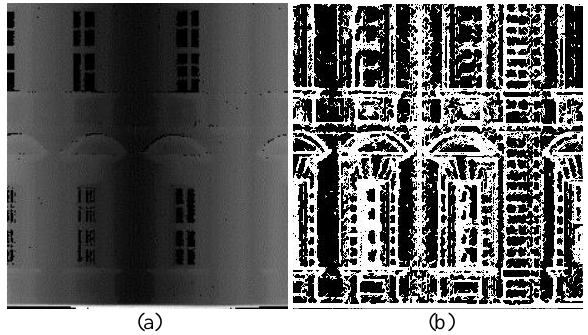
Figure 9. Regularized DSM (a) and geometric breaklines (b).